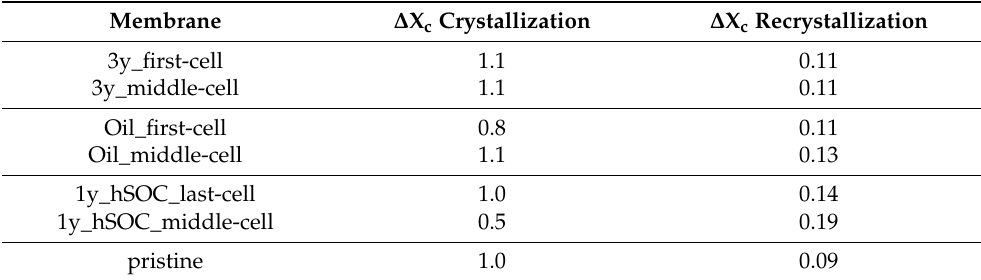
Table 2. FAP 450 membranes, retrieved from field tests and their relative crystallinity’s ∆ X c